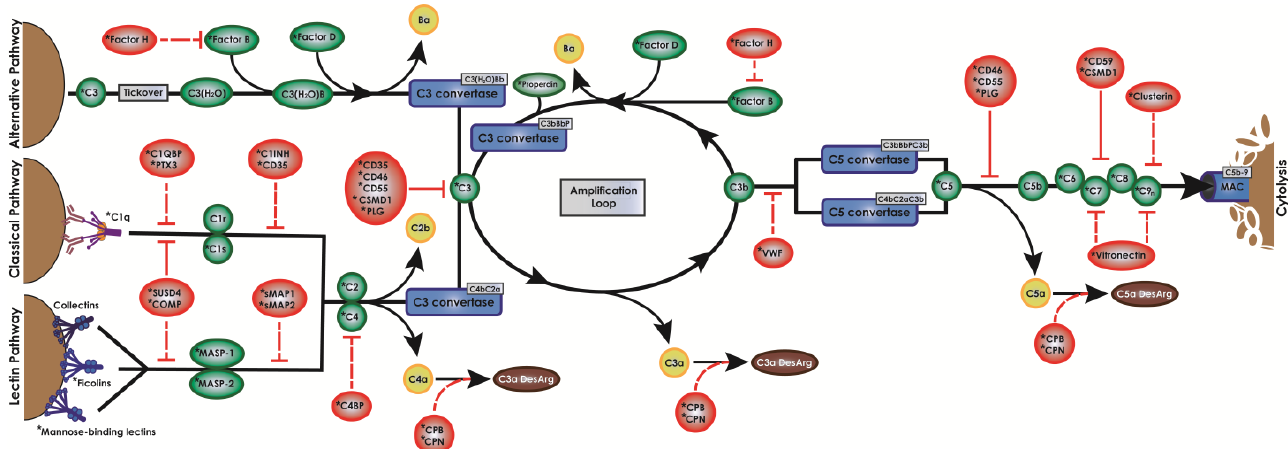
Figure 1. The complement cascade. Complement is a cytolytic cascade that can be activated sponta- neously (alternative pathway), by antibody binding (classical pathway), or by bacterial oligosaccha- rides (lectin pathway). All three pathways converge on the creation of the C3 and C5 convertases, which lead to the assembly of the MAC. Red bubbles indicate complement inhibitors. Green bubbles indicate complement cascade components. Blue bubbles indicate enzymatic convertase complexes. Yellow bubbles indicate anaphylatoxins. Brown bubbles indicate des-arginated forms of ana- phylatoxins. * indicate complement genes expressed by NPSCs.